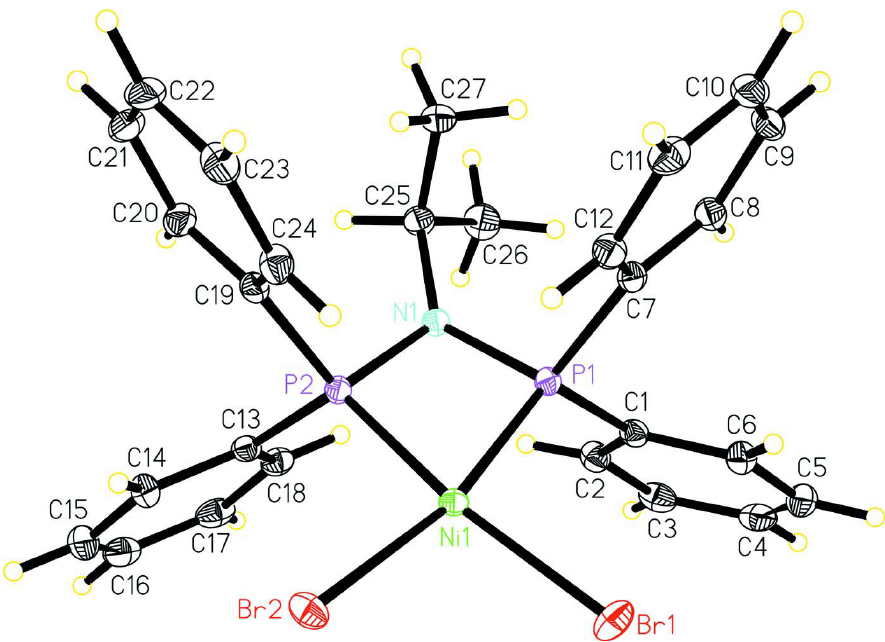
The molecular structure of the title compound showing the atom-labelling scheme. Displacement ellipsoids are drawn at the 30% probability